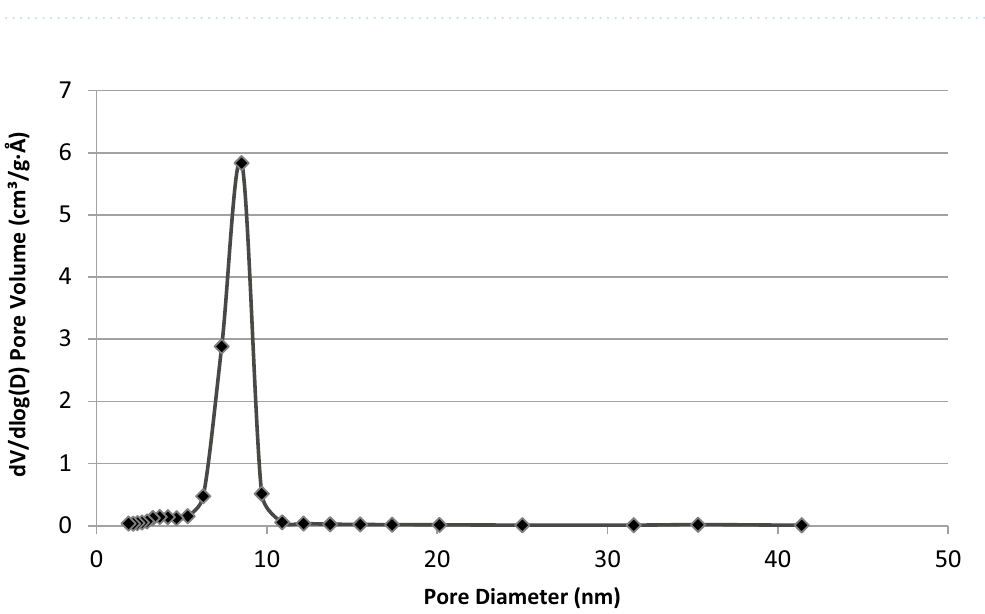
Figure 6. Nitrogen adsorption–desorption isotherms of silica nanoparticles synthesized from UKMRC-8 rice husk ash.